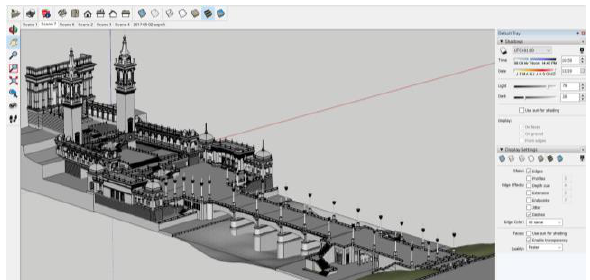
Figure 14. Desktop visualization of the Monumental complex